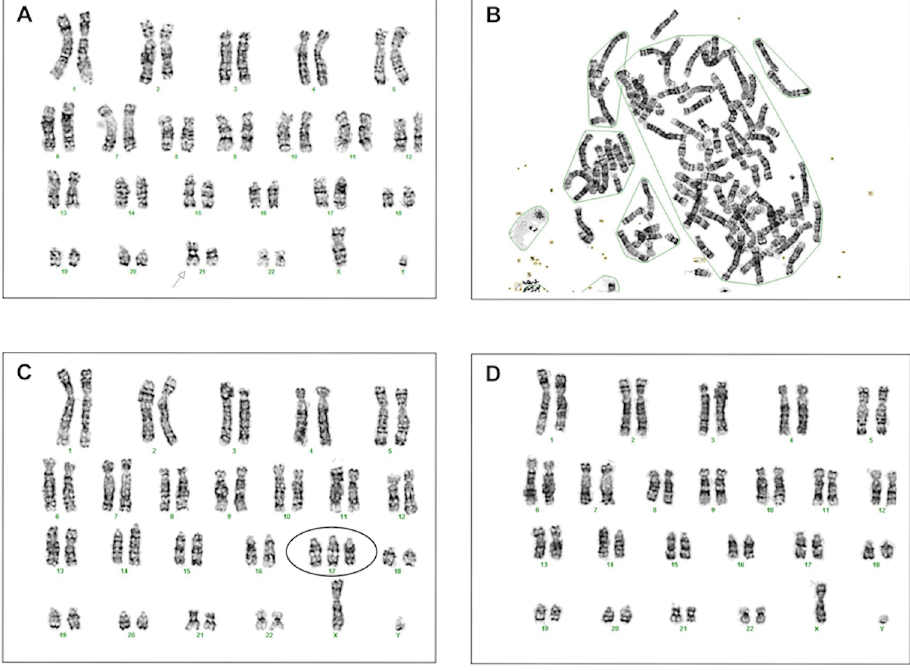
Fig 3. Karyotyping of hTERT - immortalized marmoset fibroblasts. (A) Karyotype of polyclonal line hTERT-poly with isochromosome 21q (arrow). (B) Tetraploid karyotype of monoclonal immortalized line K#4. (C) Karyotype of monoclonal line K#1 showing an extra Chromosome 17 (circled) as observed in 6/15 recorded images. (D) Normal diploid karyotype of immortalized monoclonal line K#1 as observed in 9/15 recorded images.